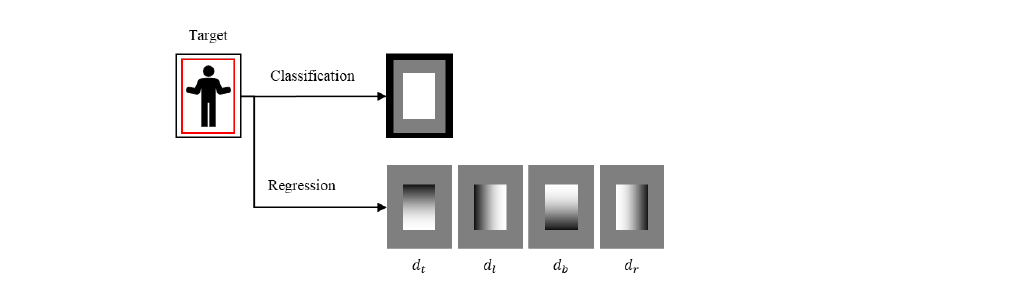
Figure 11. Classification and regression targets after being processed. The white rectangle inside the classification target is the effective area of the bounding box, the ignore area is colored in gray, and the gradients from this zone are not propagated, while the black area does not contain any object. The same goes for the regression target, but instead of one map, it has four (one for each distance between the current location and the location of the top, left, bottom and right sides of the original bounding box).